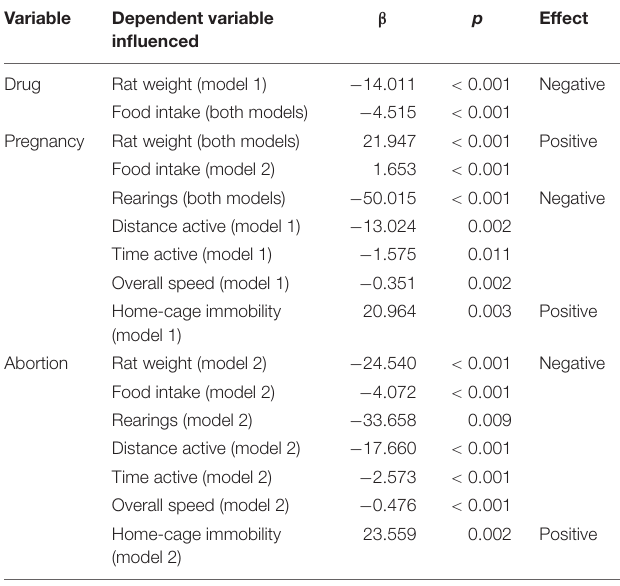
TABLE 2 | Summary of treatment variables (drug, pregnancy, abortion) as final significant predictors for biological and behavioral variables. Variable